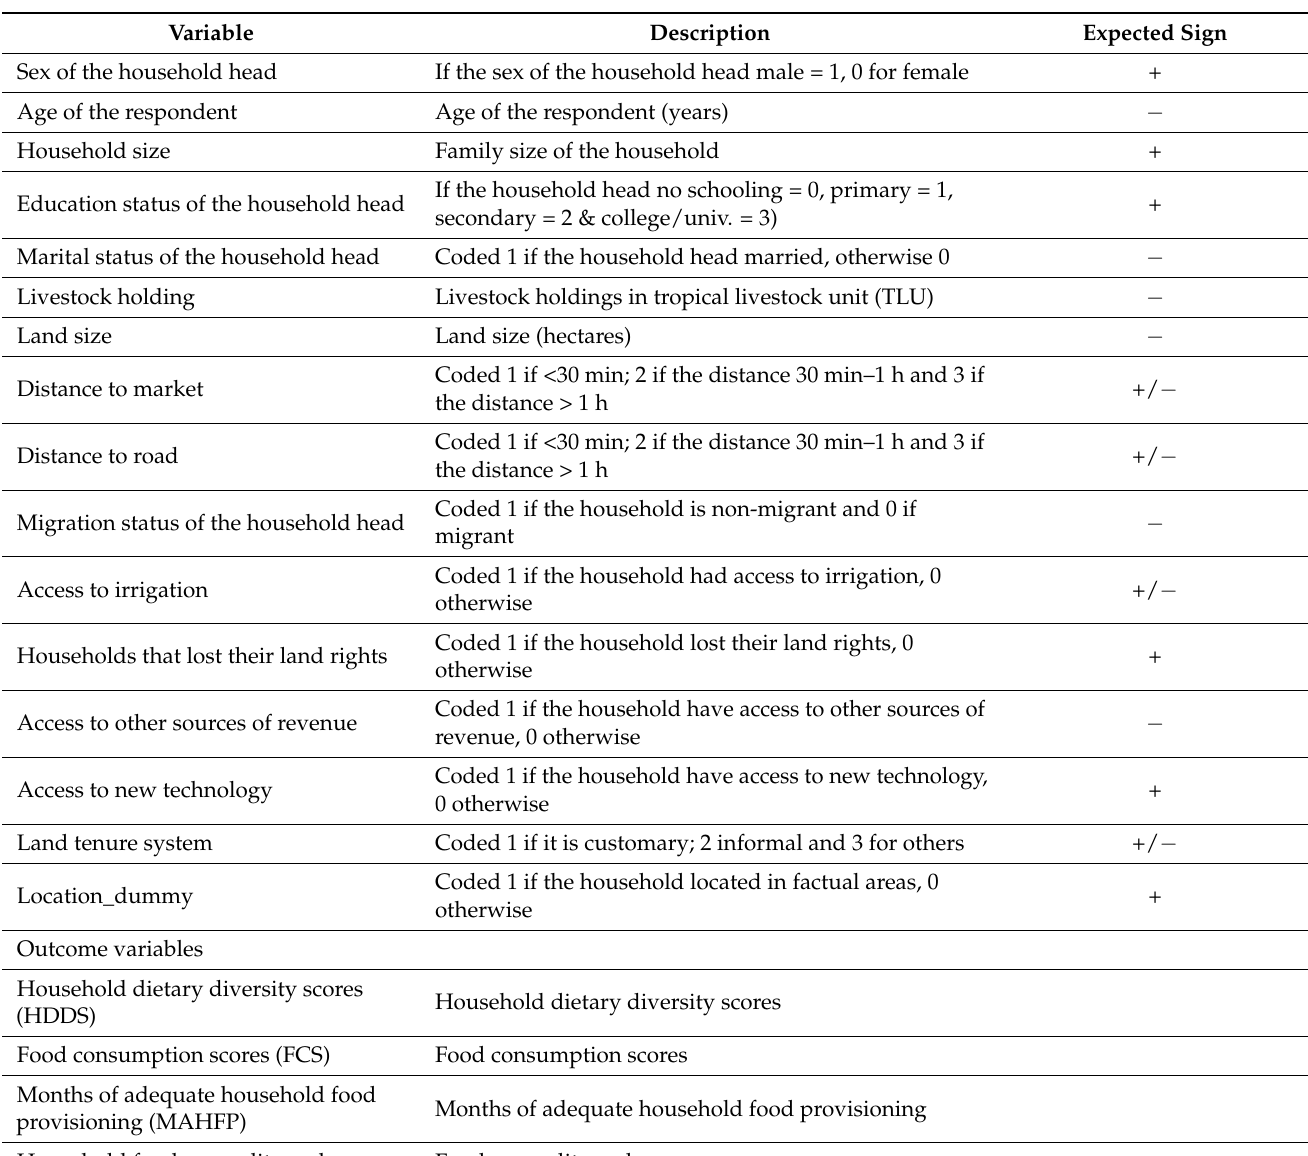
Table 3. Variable names, definitions and expected